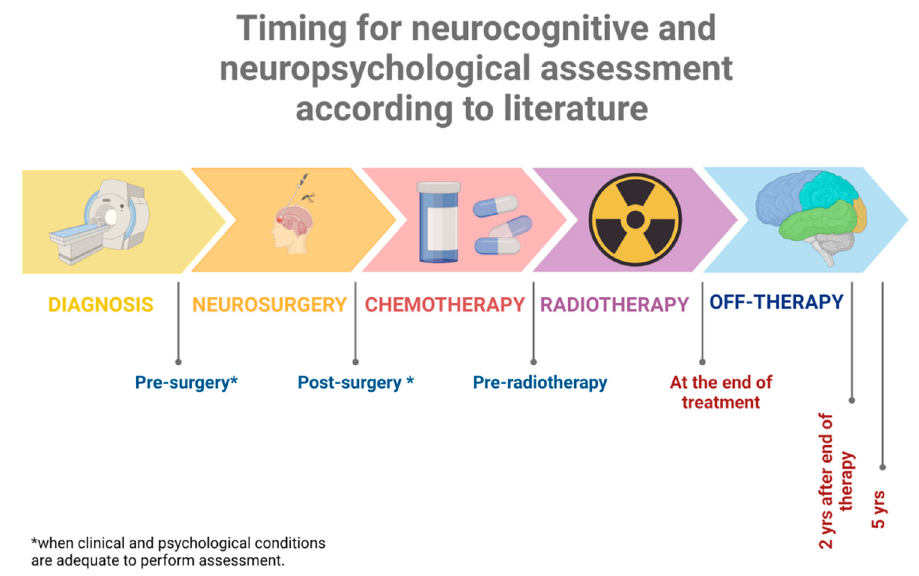
Figure 4. Timing suggested for baseline evaluation and subsequent follow-up assessments. At any time point, during treatment or after the end of therapy, a reassessment is recommended in the phase of transition to new schools or when new difficulties emerge. Created with Biorender.